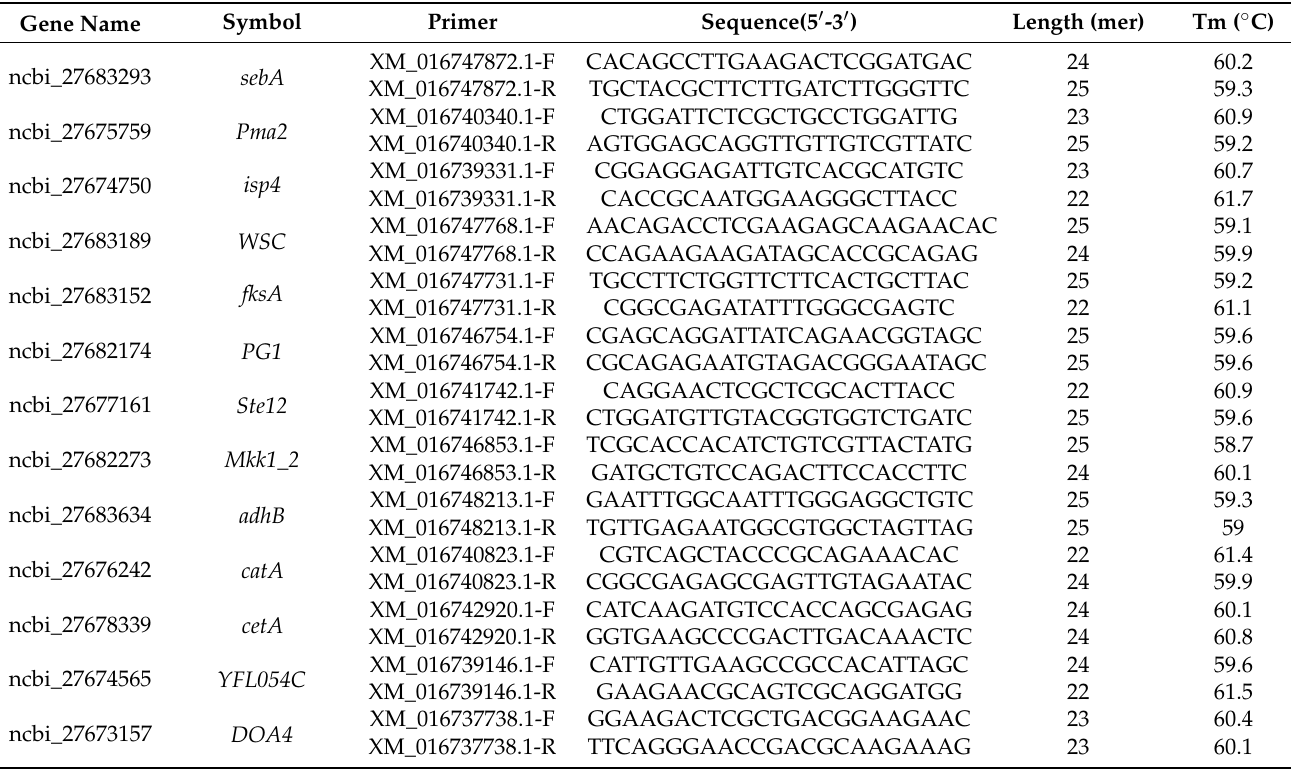
Table 1. The primers used in RT-qPCR